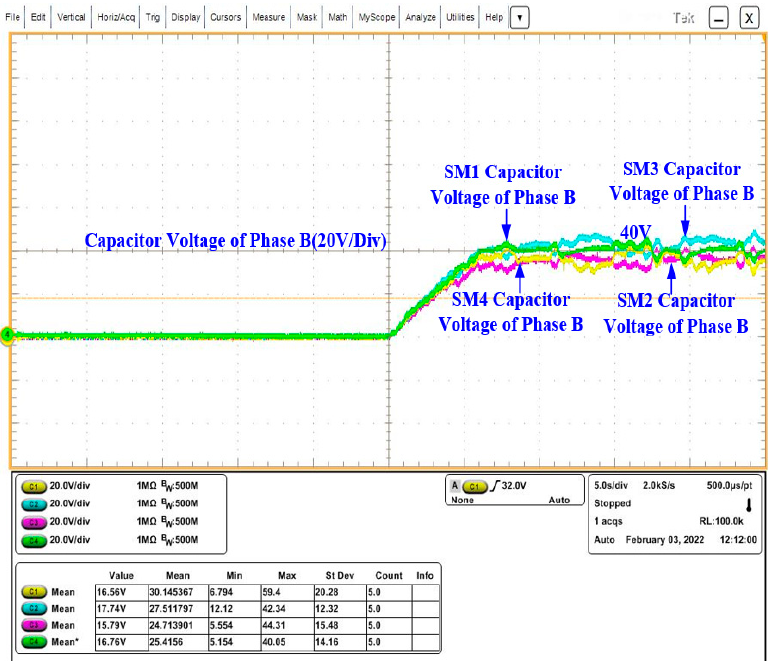
Figure 14. Dynamic performance of phase B when the reference value of the DC voltage from 0 PU to 0.8 PU.